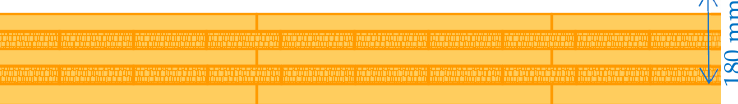
Figure 3. Configuration 1: Bare floor.